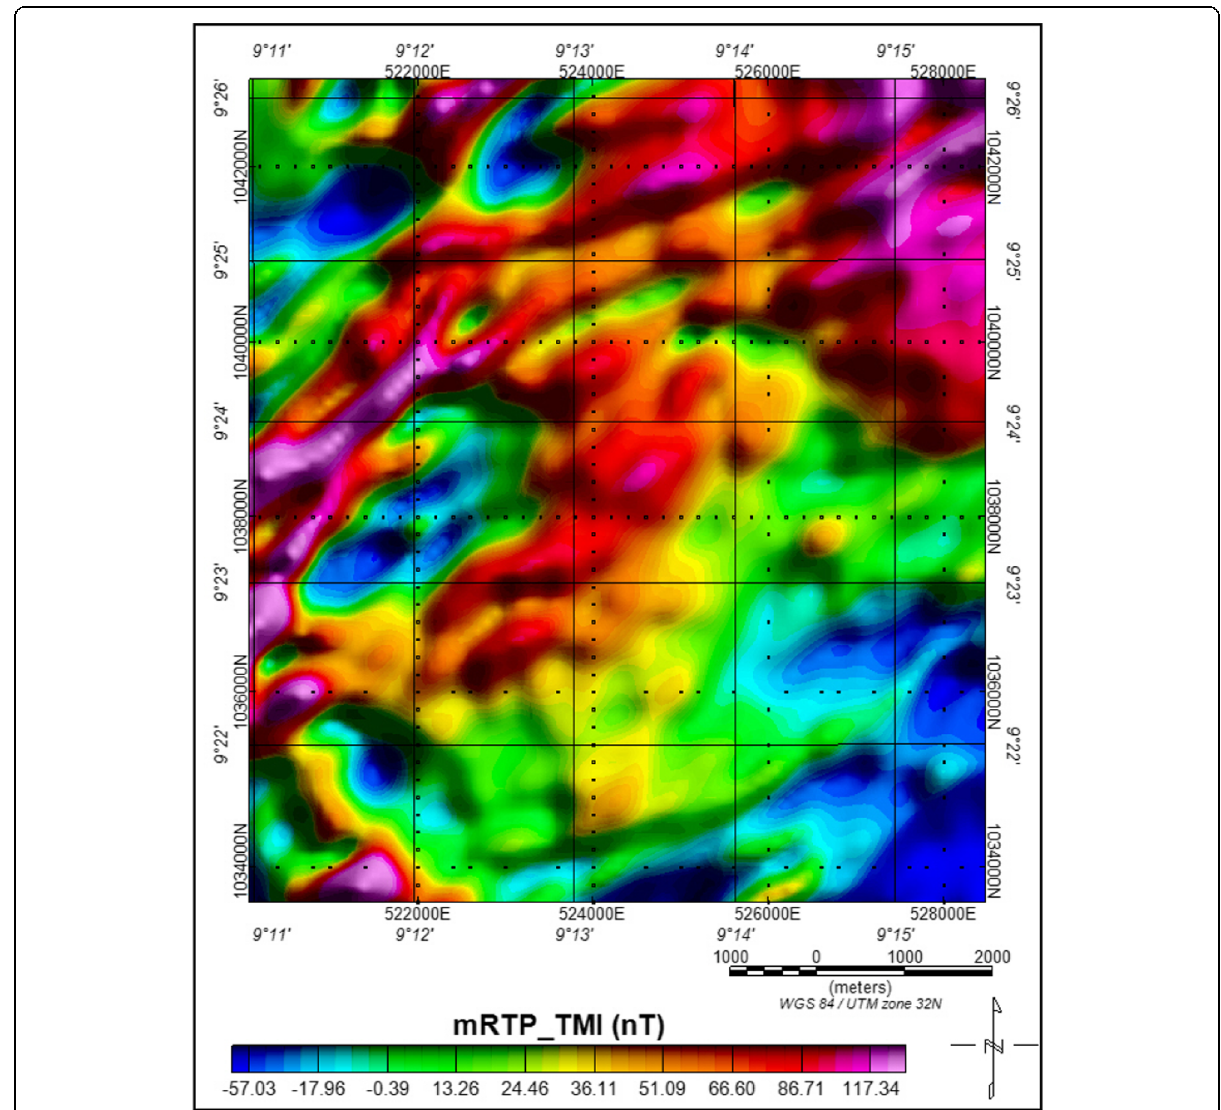
Fig. 18 Modified reduced to pole magnetic anomaly map